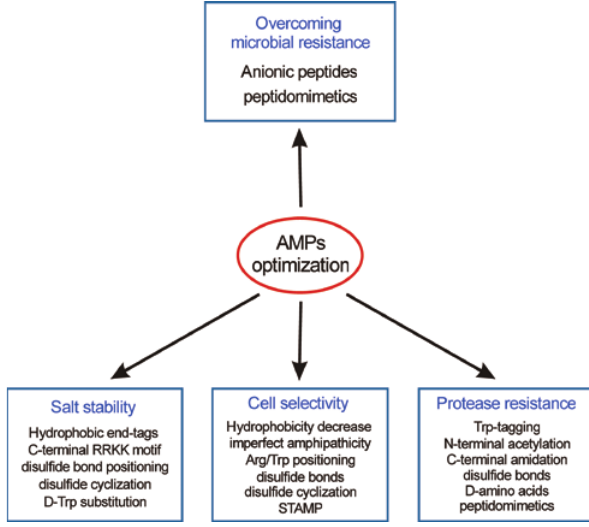
Figure 3: Selected ways to enhance therapeutic potential of AMPs. Approaches used to improve cell selectivity, salt stability, and resistance to proteolysis are summarized. Potential ways to overcome development of microbial resistance are also